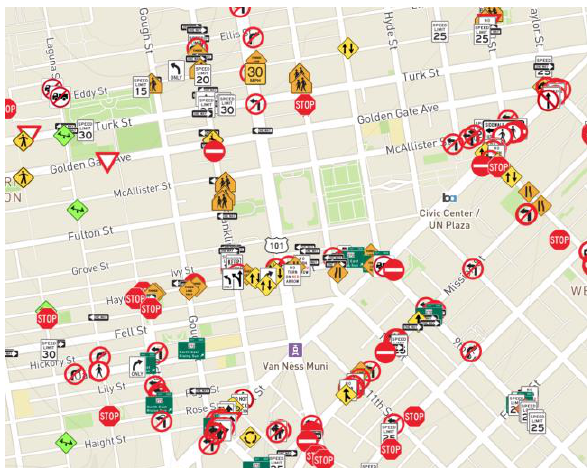
Figure 2. Example of traffic signs dataset